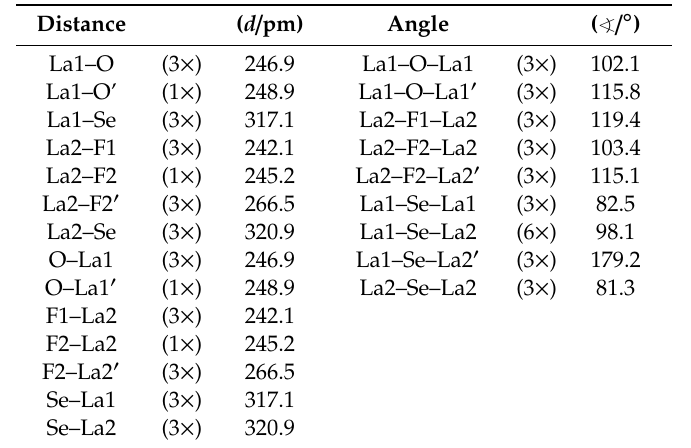
Table 4. Selected interatomic distances ( d / pm) and angles (